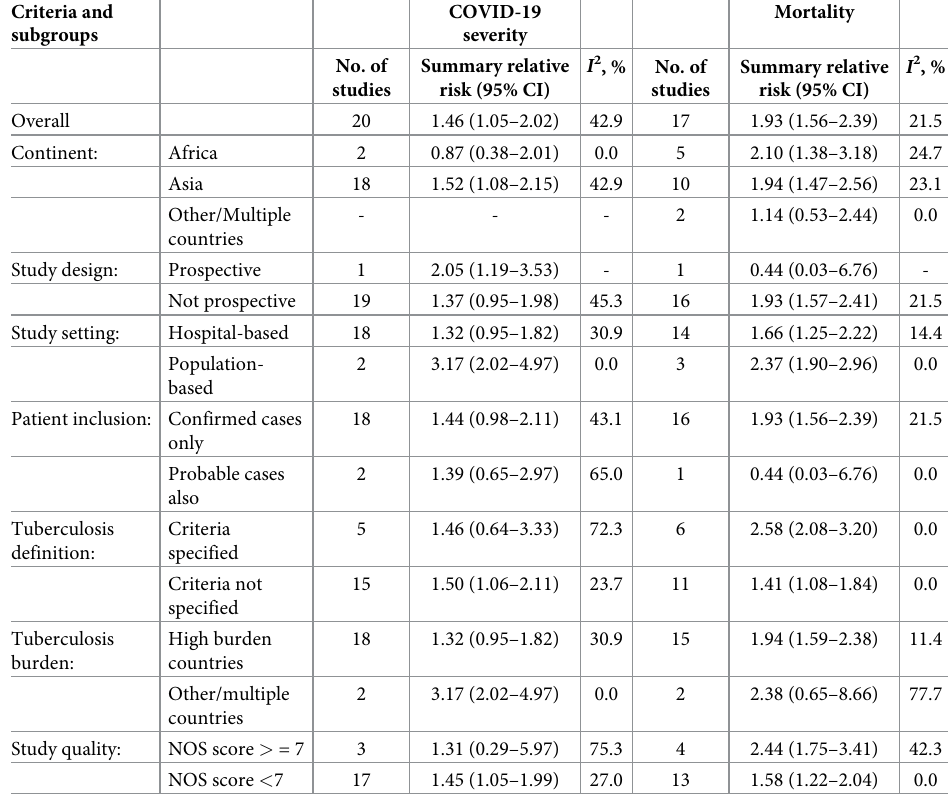
Table 3. Subgroup analysis for summary relative risk of adverse outcomes among COVID-19 patients with active pulmonary